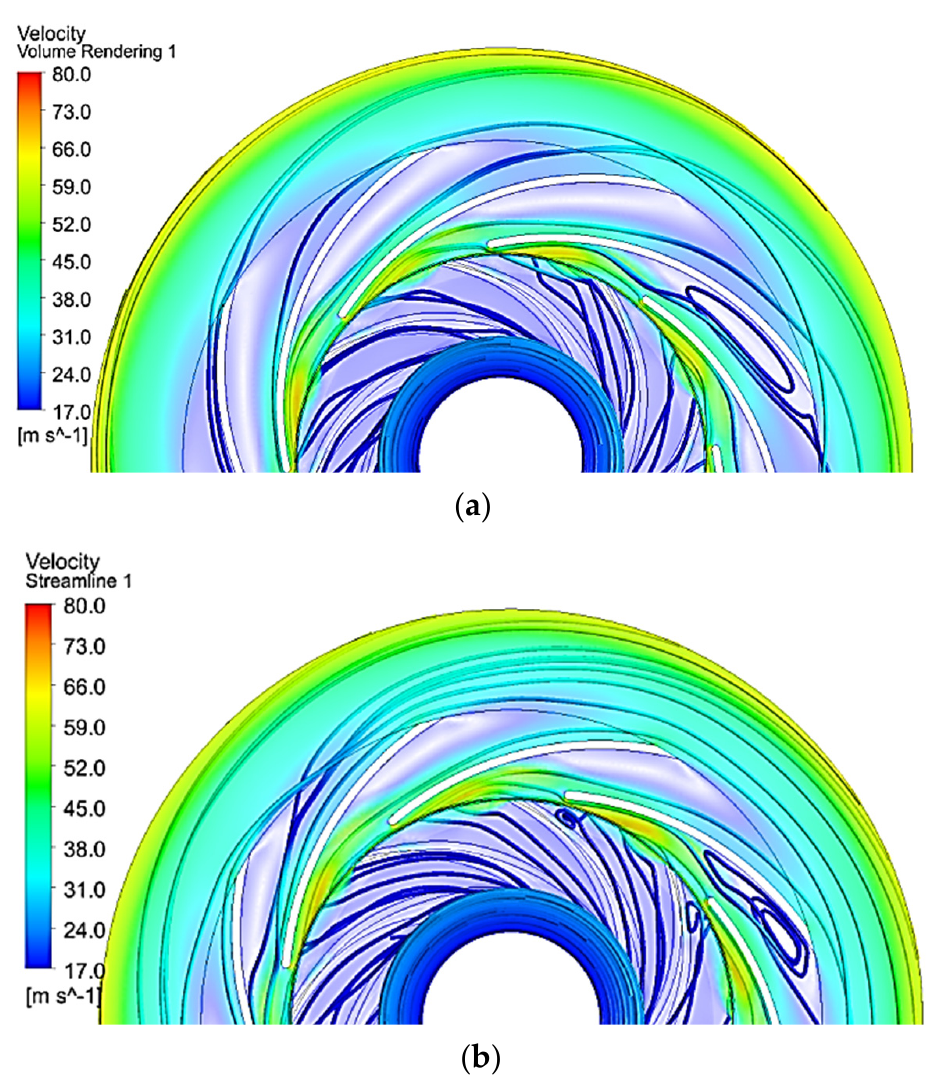
Figure 7. Stages with trimming of 20 mm: ( a ) D 4 = constant; ( b ) h = constant. The characteristics of these degrees were as follows: without trimming— H = 387 m, N = 331 kW, and η = 57%; after trimming of 52 mm— H = 184 m, N = 139 kW, and η = 65%. Thus, the impeller trimming significantly affected the pressure and energy characteris- tics of the counter-rotating stages of the centrifugal